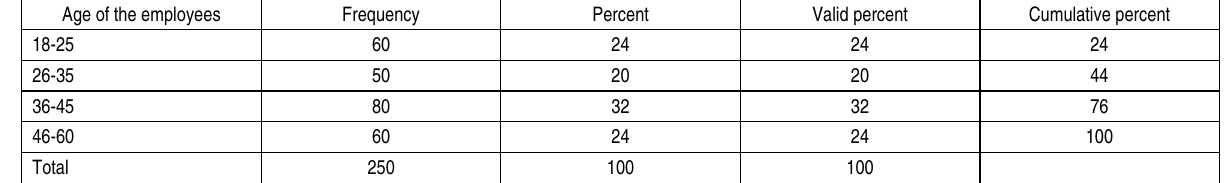
Table 2. Frequency and percentage of employees with respect to age group